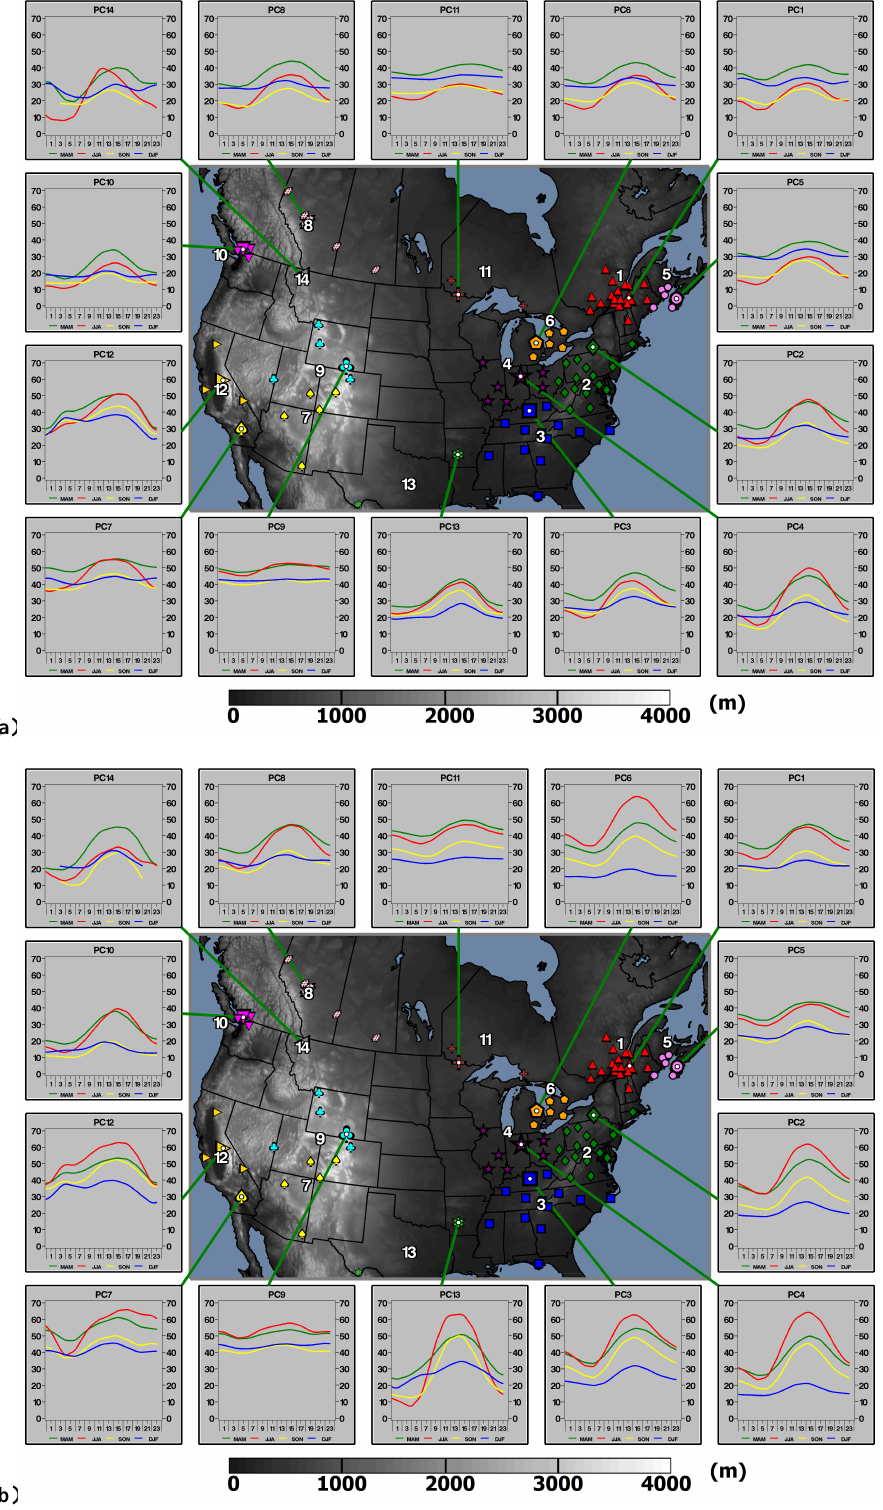
Fig. 8. (a) : Seasonally averaged ozone diurnal variations associated with the baseline air trajectory clusters grouped by rotated PCA for JJA. (b) : Seasonally averaged ozone diurnal variations associated with the most polluted air trajectory clusters grouped by rotated PCA for JJA. Vertical axes represent ozone mixing ratios (ppb) and the tickmarks on the horizontal axes represent the start of each hour in local standard time